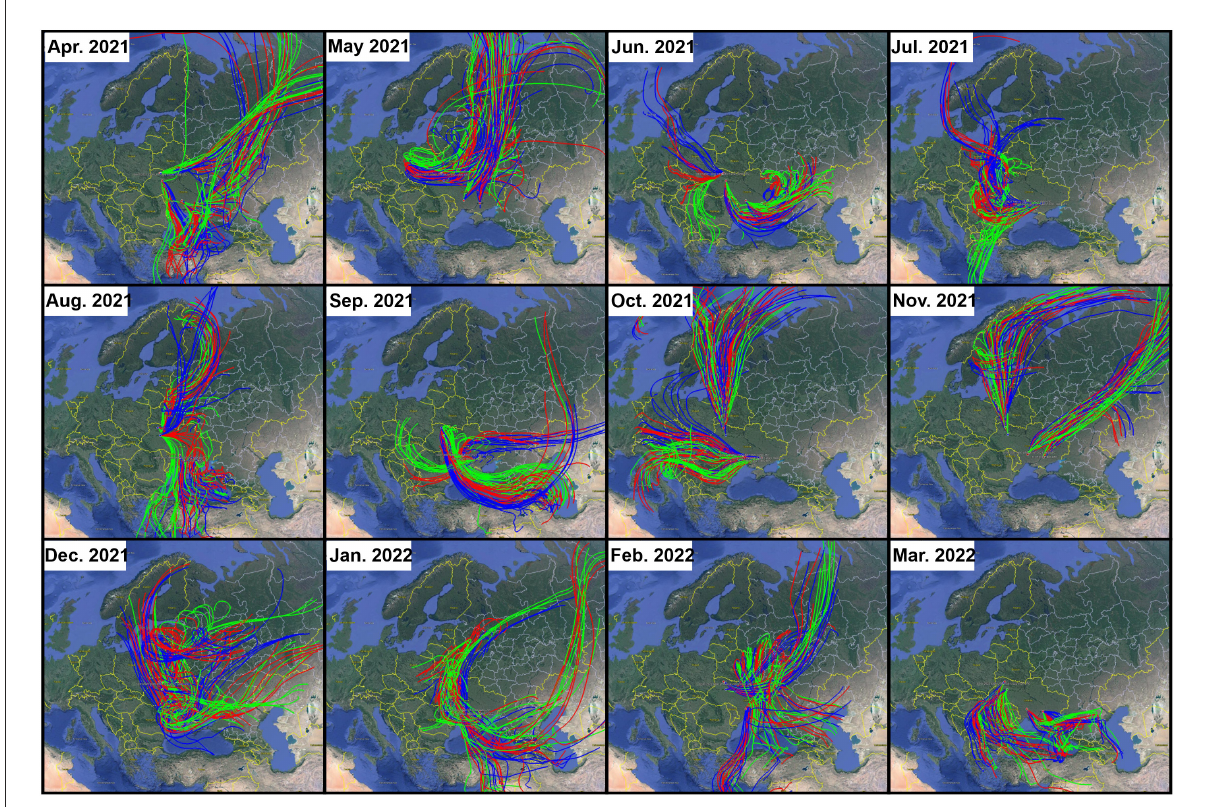
FIGURE2 Three-day forward trajectory for the studied sites for the first week of each month starting from April 2021 to March 2022. Base map is from Google